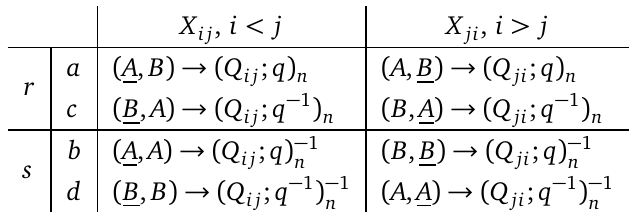
Table 1: The contribution X to the open string partition function in a strip geometry ij with a single brane attached to an external leg of the i -th vertex. Vertices i and j are of type A or B , and the underlined symbol denotes the position of the